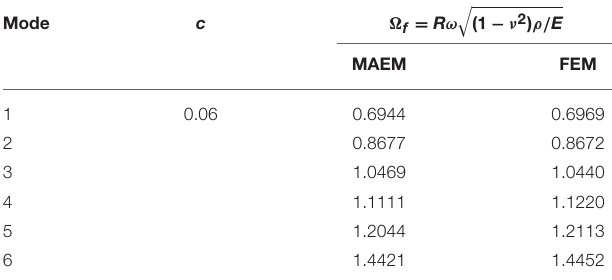
TABLE 1 | Eigenfrequency parameters of the shell in Example